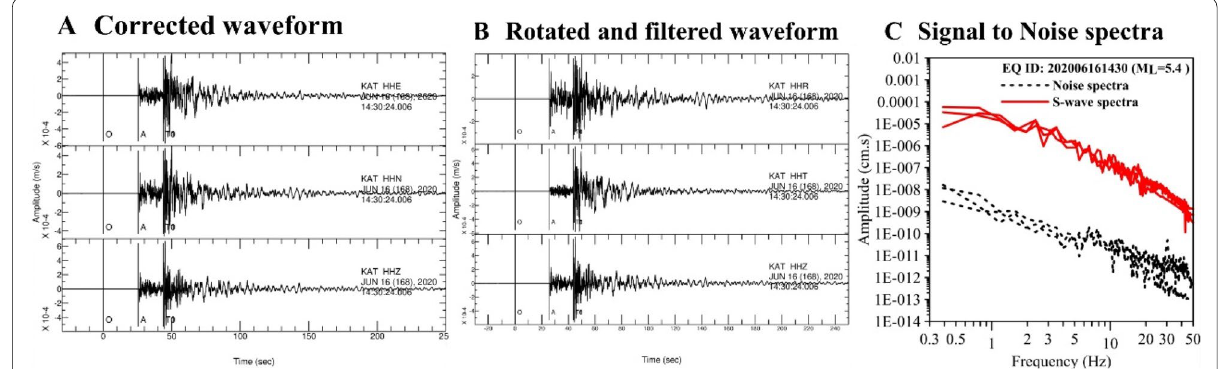
Fig. 3 A The corrected waveform data, B the rotated and filtered waveform, and C example of the obtained signal-to-noise ratio at KAT seismic station for the main shock of the 16 Jun, 2020 earthquakes sequences